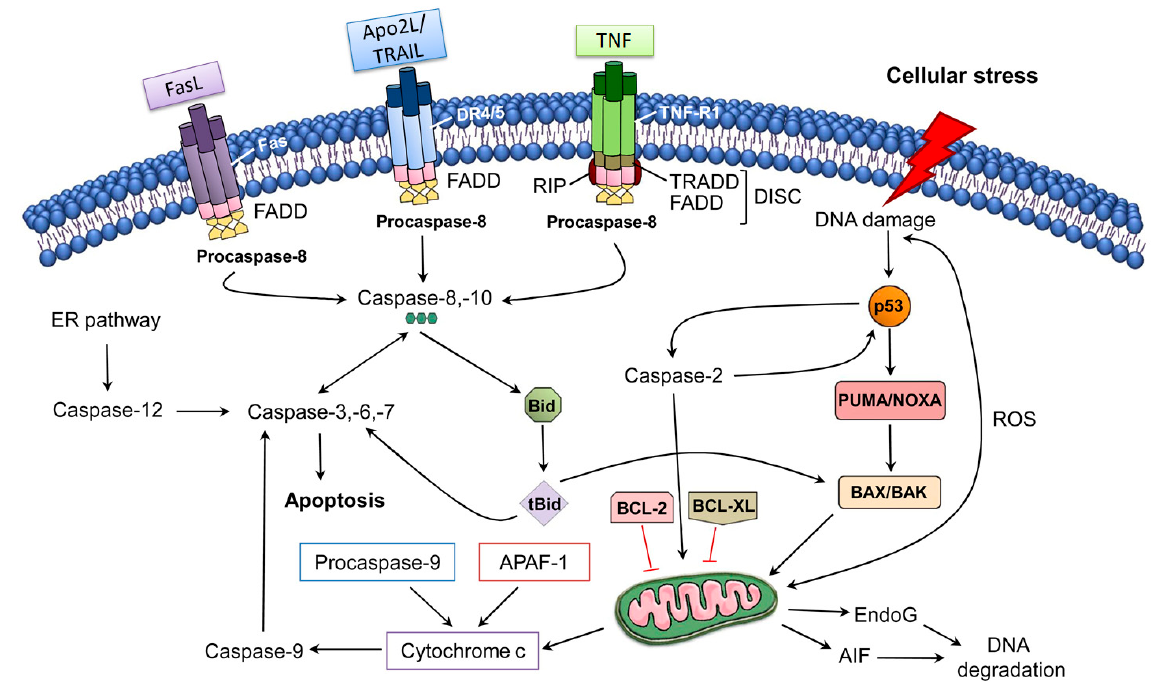
Figure 1. The extrinsic and intrinsic pathways of apoptosis [92]. Abbreviations: AIF, apoptosis-inducing factor; APAF-1, apoptotic Protease Activating Factor-1; Apo2L/TRAIL, Apo2 ligand or tumor ne-crosis factor-related apoptosis-inducing ligand; BCL-2, B-cell lymphoma 2; BCL-XL, B-cell lym-phoma-extra-large; Bid, BH3-interacting domain death agonist; DISC, death-inducing signaling complex; DR4/5, death receptor 4/5; EndoG, endonuclease G; ER, endoplasmic reticulum; FADD, FAS-associated death domain protein; FasL, Fas Ligand; PUMA, p53 upregulated modulator of apoptosis; ROS, reactive oxygen species; tBid, truncated Bid; TNF-R1, tumor necrosis factor receptor 1. Figure adapted with permission from Ref [92]. Copyright 2014, Elsevier.